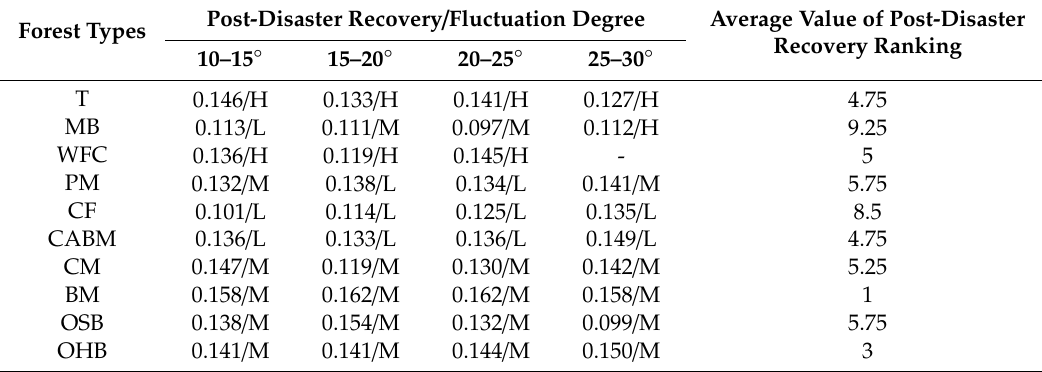
Table 11. Post-disaster recovery and fluctuation-degree analysis results for di ff erent forest types in four slope zones.